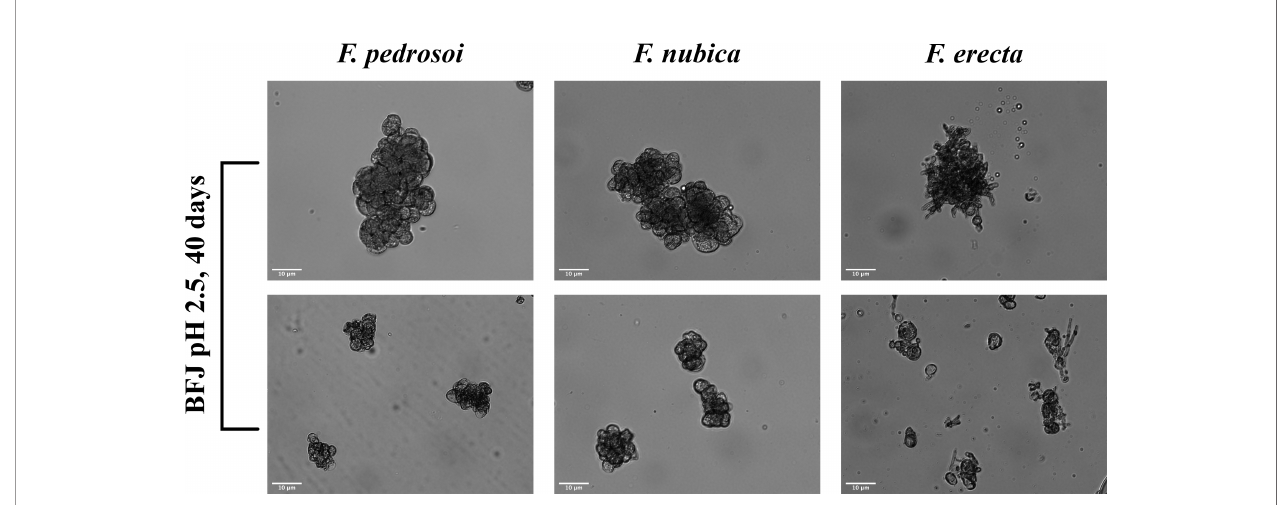
FIGURE 1 | F. pedrosoi , F. nubica , and F. erecta can induce different types of muriform cell formation in vitro . Representative images of muriform cells produced by F. pedrosoi, F. nubica, and F. erecta . Micrographs were acquired with the inverted epi fl uorescence microscope Zeiss Axio Observer Z1 with a 40x objective, and bright- fi eld images were processed and analyzed by Zeiss ZEN and ImageJ software, respectively. Scale bars: 10 µm. The results presented in this work refer to a representative triplicate group experiment of at least two independent